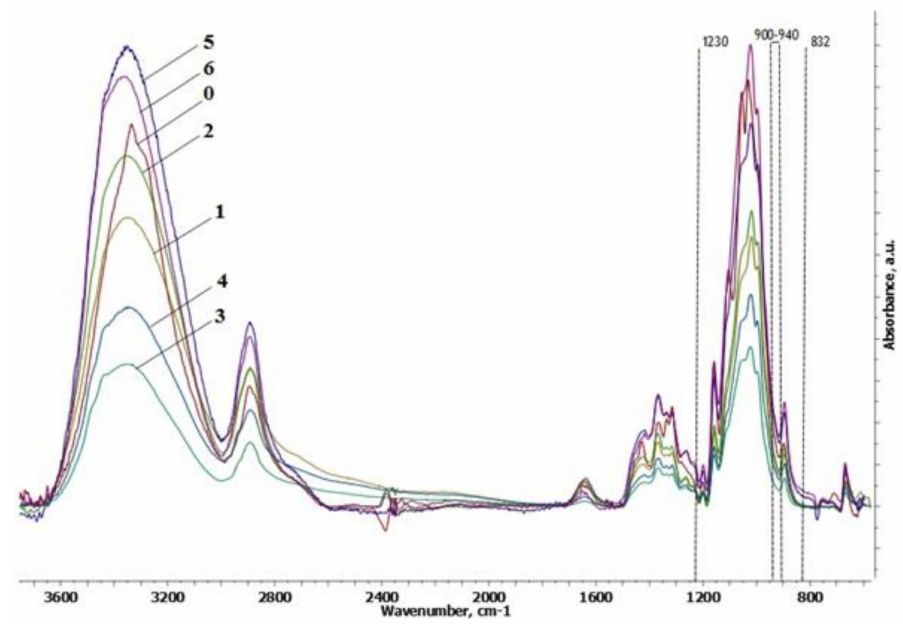
Figure 2. FTIR spectra of microcrystalline cellulose (0) and cellulose cryogel samples (numbers according to Table 1).